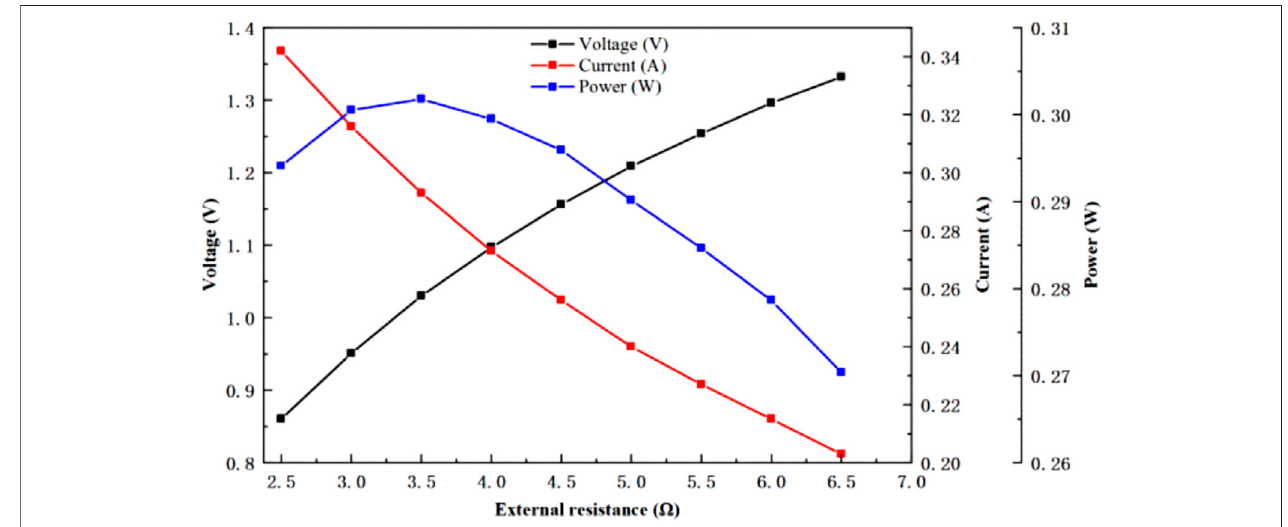
FIGURE 6 | Power performance curve with